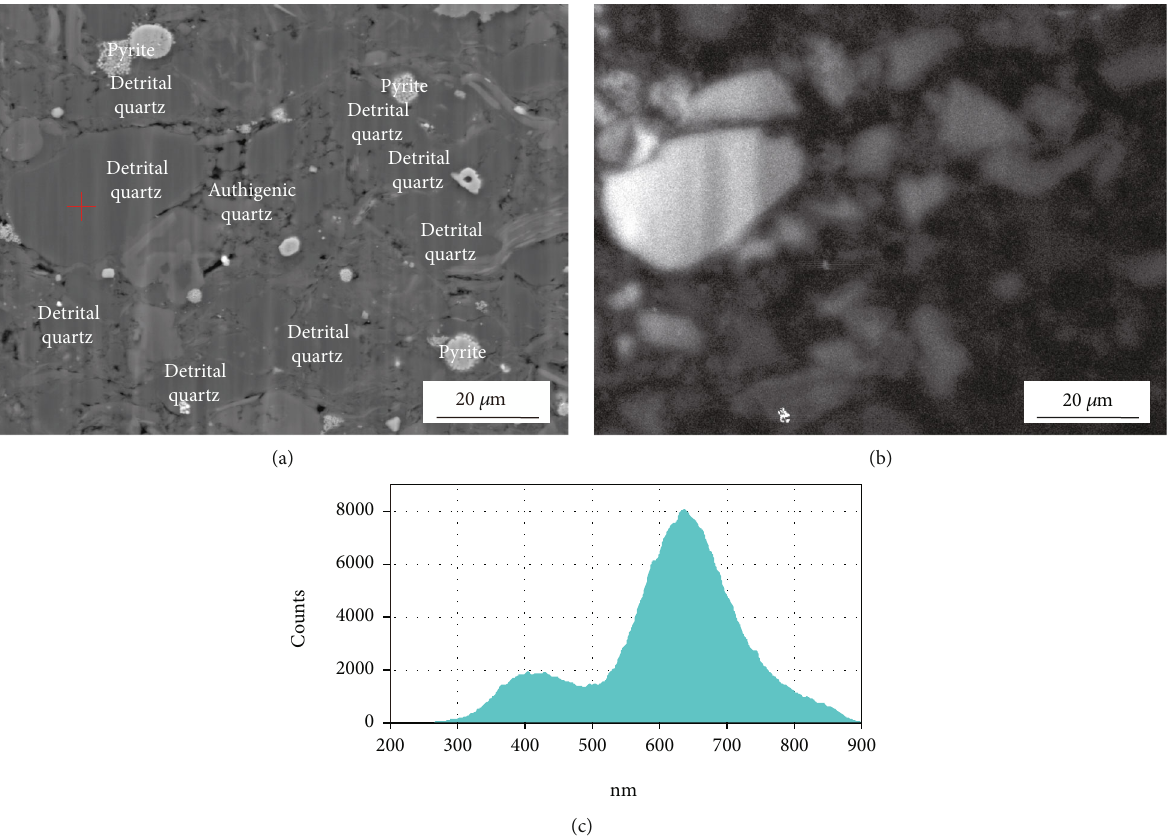
Figure 8: BSE images, cathodoluminescence (CL) image, and CL-response images of siliceous shale samples from the Wufeng and Longmaxi Formations. (a) BSE image of detrital quartz silt with pore- fi lling authigenic quartz, Wufeng Formation, 2532.11m, well JY 2. (b) SEM-CL image displaying the strong luminescence of quartz silt grain. (c) Monochromatic CL-responses of quartz silt (blue cross in